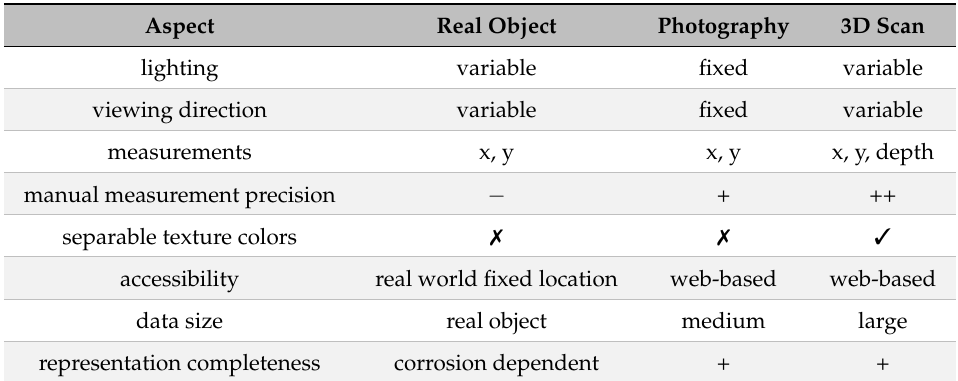
Table 1. Collation accessibility features on different types of original media.